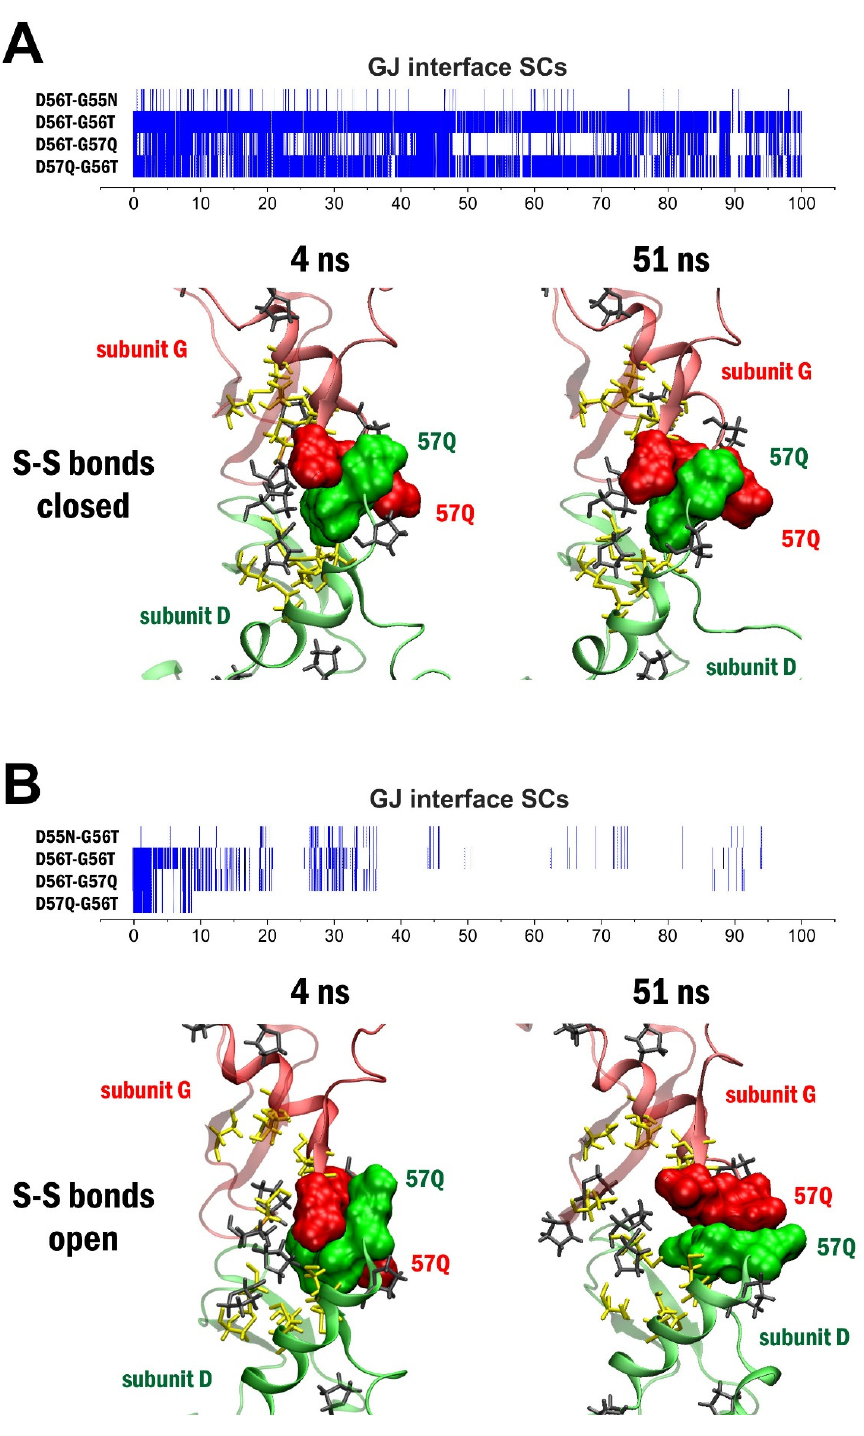
Figure 4. Forming of GJ interface SCs 55 N -56 T -57Q is governed by neighboring Cys residues. ( A ): Dynamics of GJ interface SCs between the D and G subunits during the closed disulfide MD run of Cx43 GJC (top). Bottom: 55 N , 56 T and 57Q residues (shown by surface representation) constitute the GJ interface stabilization centers (SCs) between the opposing subunits D (green) and G (red). The GJ interface SCs are fairly stable during the 100 ns molecular dynamics simulation. ( B ): Dynamics of GJ interface SCs between the D and G subunits during the open disulfide MD run of Cx43 GJC (top). Bottom: opening of S-S bonds at the beginning of the simulation leads to weakening of SC contact interactions between the 55 N -56 T -57Q surfaces and disruption of the SCs (bottom row). Color code: green–subunit D; red–subunit G; yellow–Cys residues; gray–Pro